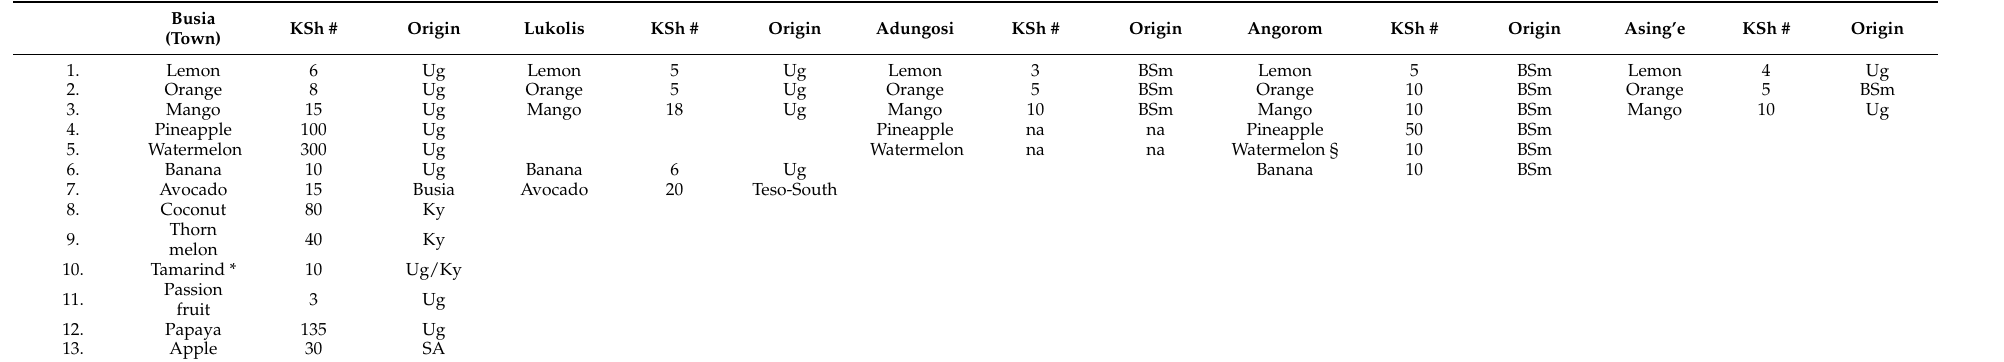
Table 2. Fruits, price per piece and origin available at markets accessed by study participants end of July